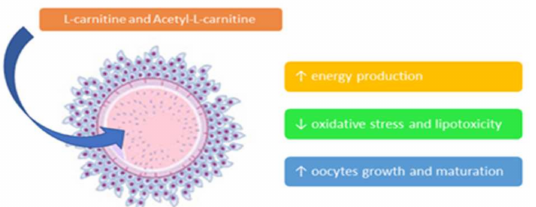
Figure 3. Role of L-carnitine and acetyl-L-carnitine on the cumulus-oocyte complex. V á rnagy et al., in 2013, studied carnitine profiling of women undergoing IVF and suggested that L-carnitine metabolism is accelerated and the developmental competence of oocytes and early embryos can be optimized by giving supplemental L-carnitine